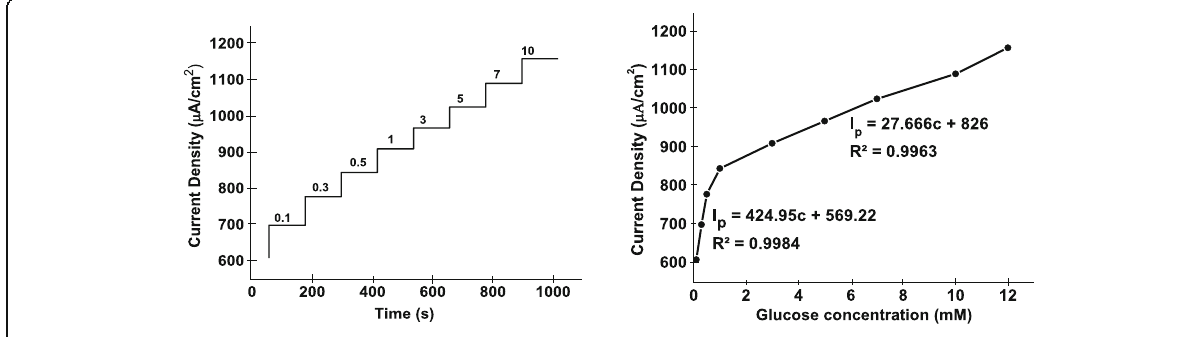
Fig. 11 a Chronoamperometric response of GO/CuO/FTO. b Calibration curve